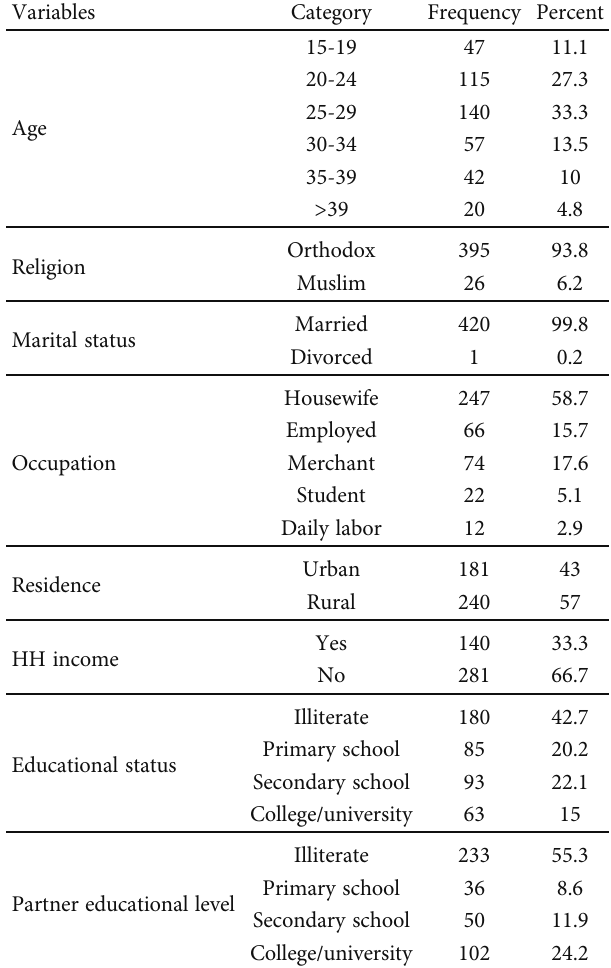
Table 1: Sociodemographic characteristics of pregnant women attending antenatal care at Jabi Tenhan District health centers in April 2021 ( n = 421